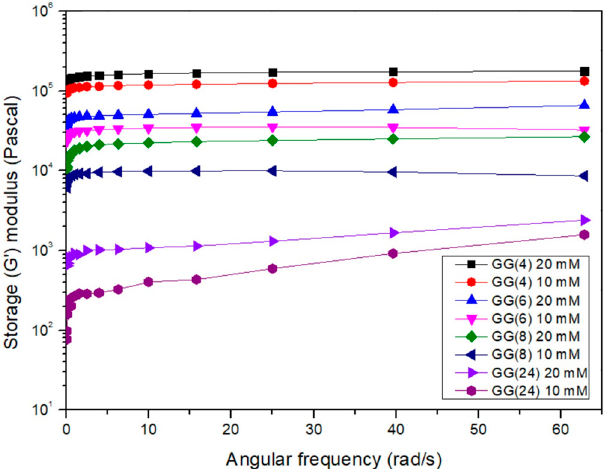
Figure 4. Elastic moduli (G’) obtained from frequency sweep rheograms performed at 1% of strain on GG ionotropic crosslinked hydrogels with different CaCl 2 concentrations.